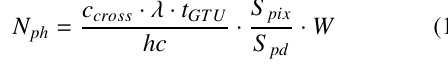
Figure 7. Left: “top-4 response map”, right: scheme of pixel borders obtained during scan